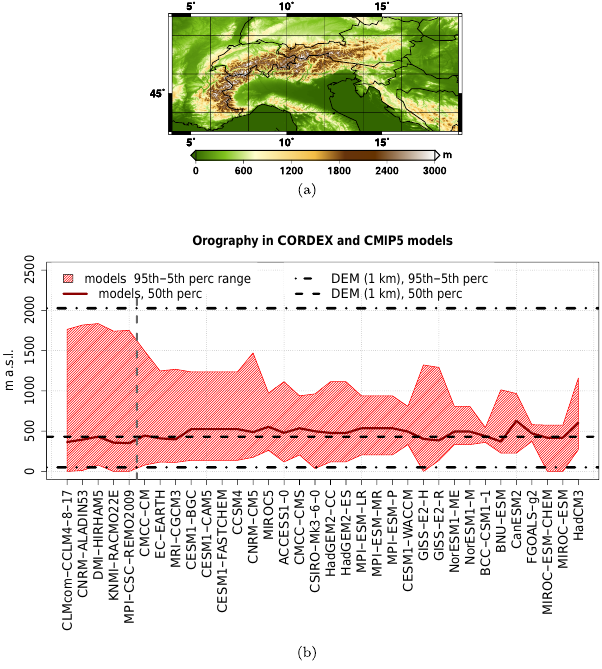
Figure 1. (a) Orography of the greater Alpine region (4–19 ◦ E; 43–49 ◦ N) as in the GLOBE 1km digital elevation model (DEM). (b) The 95th (dash-dotted), 50th (dashed) and 5th (dash-dotted) percentiles of the elevation distribution in the DEM compared to the corresponding values obtained from the CORDEX and CMIP5 model orographies. RCM and GCM models are ordered along the x -axis from finest to coarsest spatial resolution. RCMs and GCMs are separated by a vertical dashed